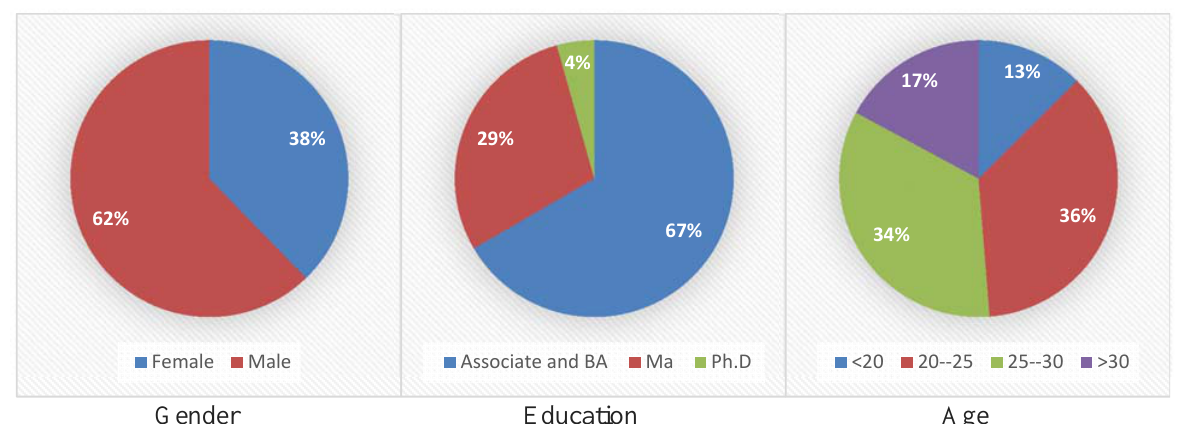
Fig. 2. Personal characteristics of the participants